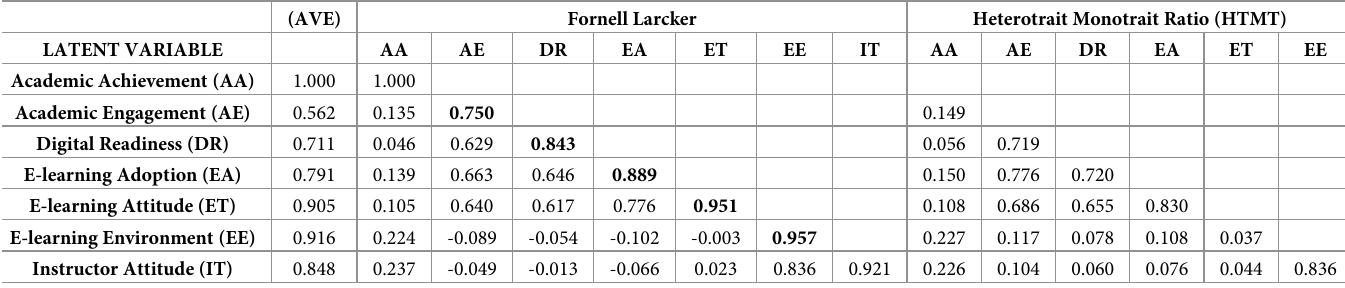
Table 3. Discriminant validity analysis.